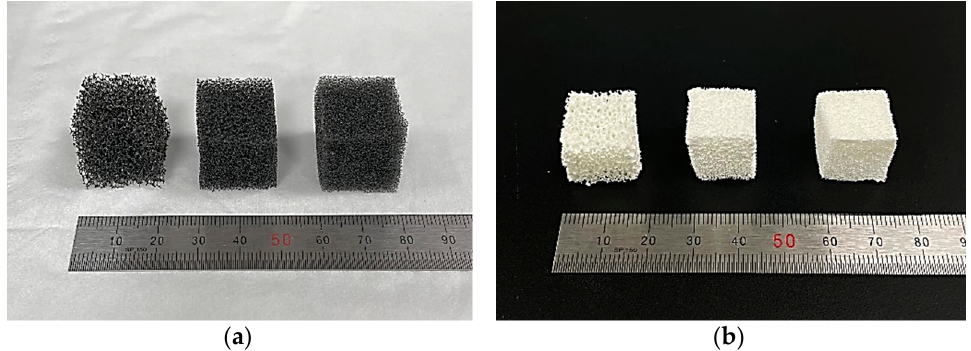
Figure 1. Optical images of ( a ) the sacrificial polymer templates (commercial polyurethane foam), with pore densities of 25, 45, and 60 PPI, and ( b ) the reticulated porous zirconia specimens, with pore densities of 25, 45, and 60 PPI, prepared through the replica method .